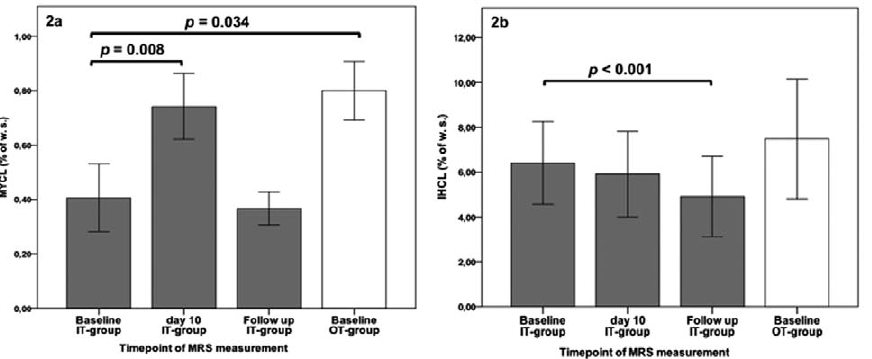
Figure 2. Intramyocardial lipid- (MYCL, given in % of water signal [w. s.]) (a) and intrahepatic lipid concentration (IHCL, given in % of water signal [w. s.]) at baseline, day 10 of IT and during follow up (181 ± 49 days) (b). Gray bars indicate IT-group and empty bar the OT- group; error bars delineate SEM.